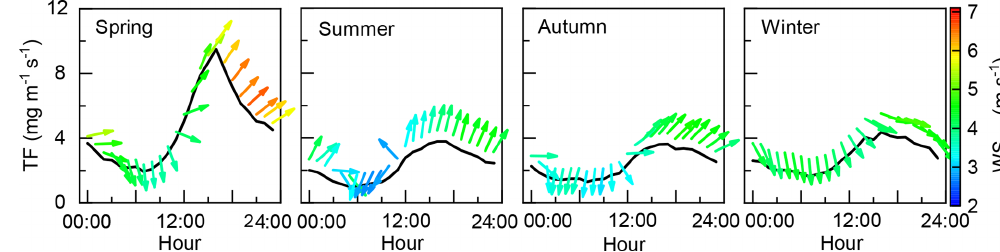
Figure 5. Diurnal variations in the mixing layer TF of PM 2 . 5 and transport direction during different seasons in Beijing.